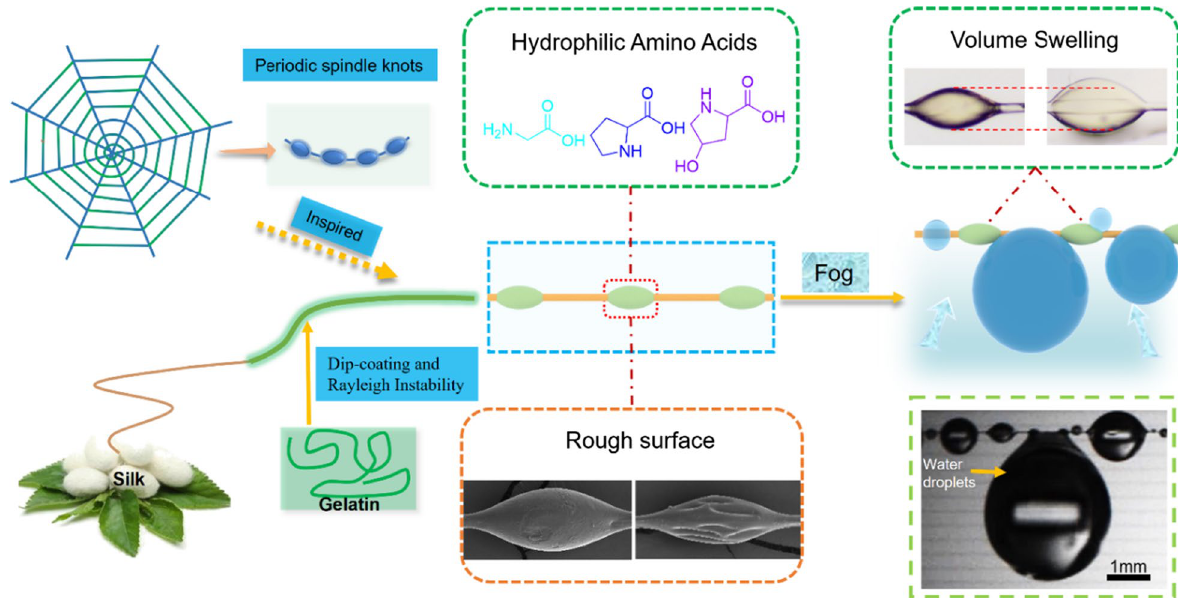
Fig. 1 Schematic illustration of the preparation and fog collection ability of